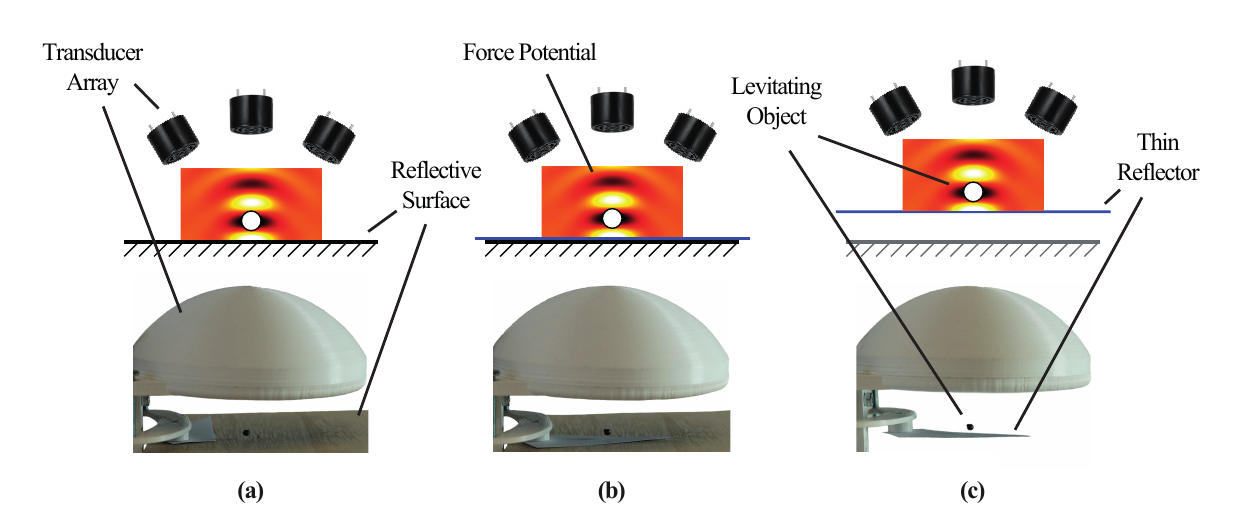
Figure 8. Gripping process of an object resting on an acoustically reflective surface using a thin reflector. ( a ) A standing wave between the transducer arrangement and an acoustically reflective surface is formed that traps the object at the first pressure minimum of the standing wave. ( b ) A thin reflector is inserted directly above the reflective surface and ( c ) the arrangement, reflector, and levitating object can be moved away from the reflective